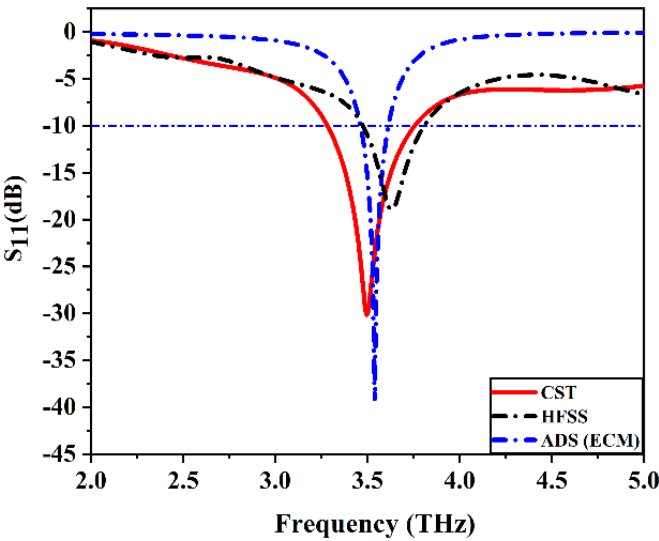
Figure 5. |S 11 | of the single element graphene plasmonic patch antenna with different simulation programs.